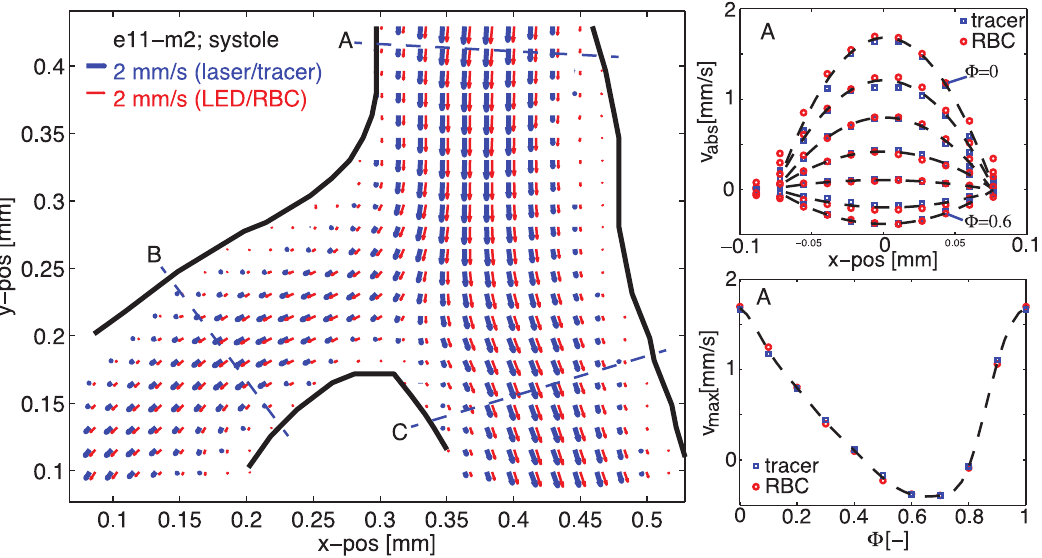
Figure 3. Results obtained at M ~ 12 : 5 | . (Left) : Superposition of the vector fields using fluorescent tracers (bold, blue vectors) and red blood cells (red vectors) at systole; a small off-set is used between the vector fields for clarity. (Top right) : velocity magnitude for both methods along profile A for 7 subsequent cardiac phases, W ~ 0,0 : 1 ... 0 : 6 ; artificial tracer ( % ) and RBCs ( 0 ). (Bottom right) : Centerline velocity at profile A during the cardiac cycle for both